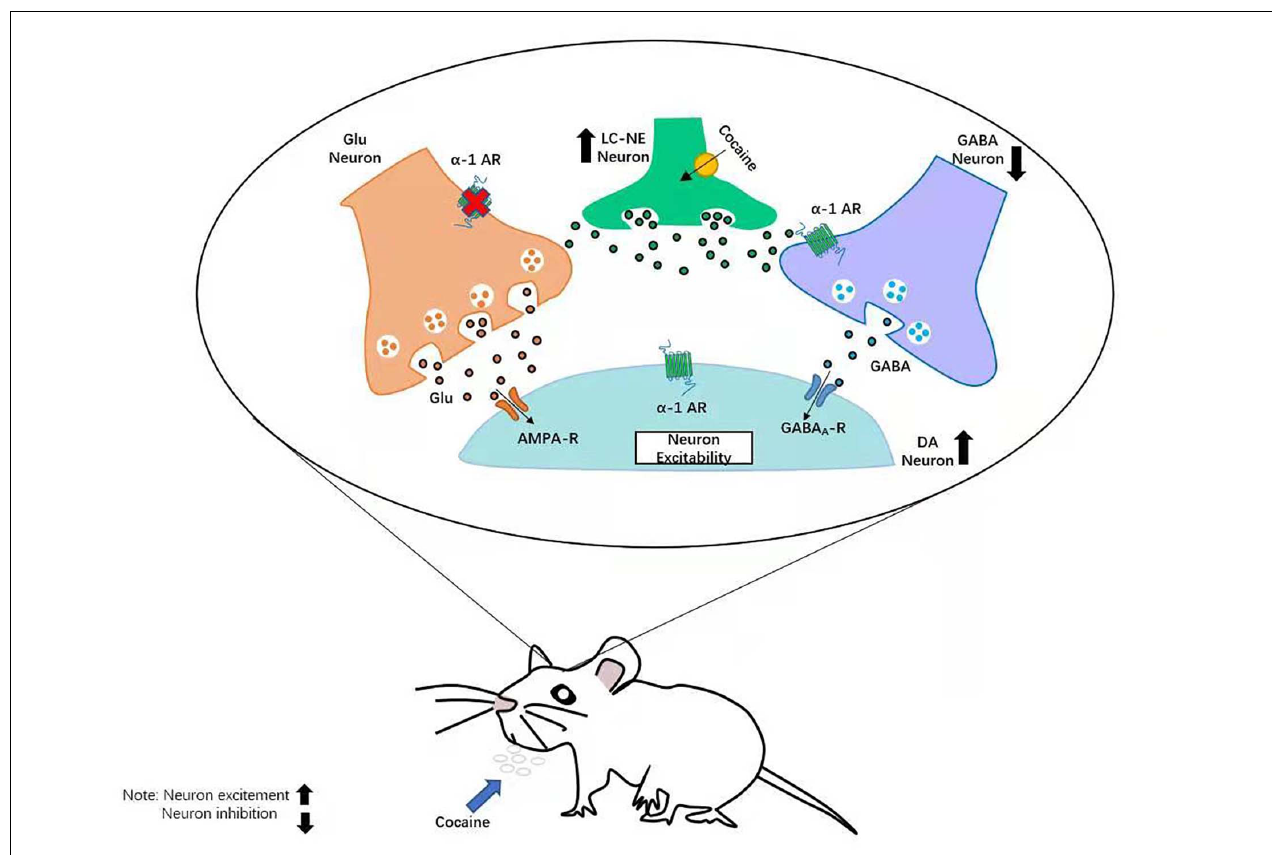
FIGURE 2 | Neural mechanism of LC–NE affecting DA in addictive behavior. LC, locus coeruleus; NE, norepinephrine; DA,